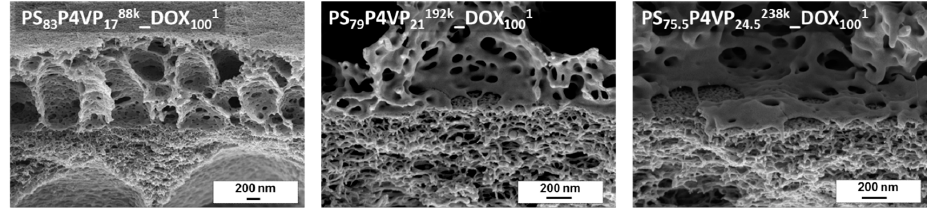
Figure 5. SEM cross-sectional images of the interface between PS- b -P4VP to PAN.